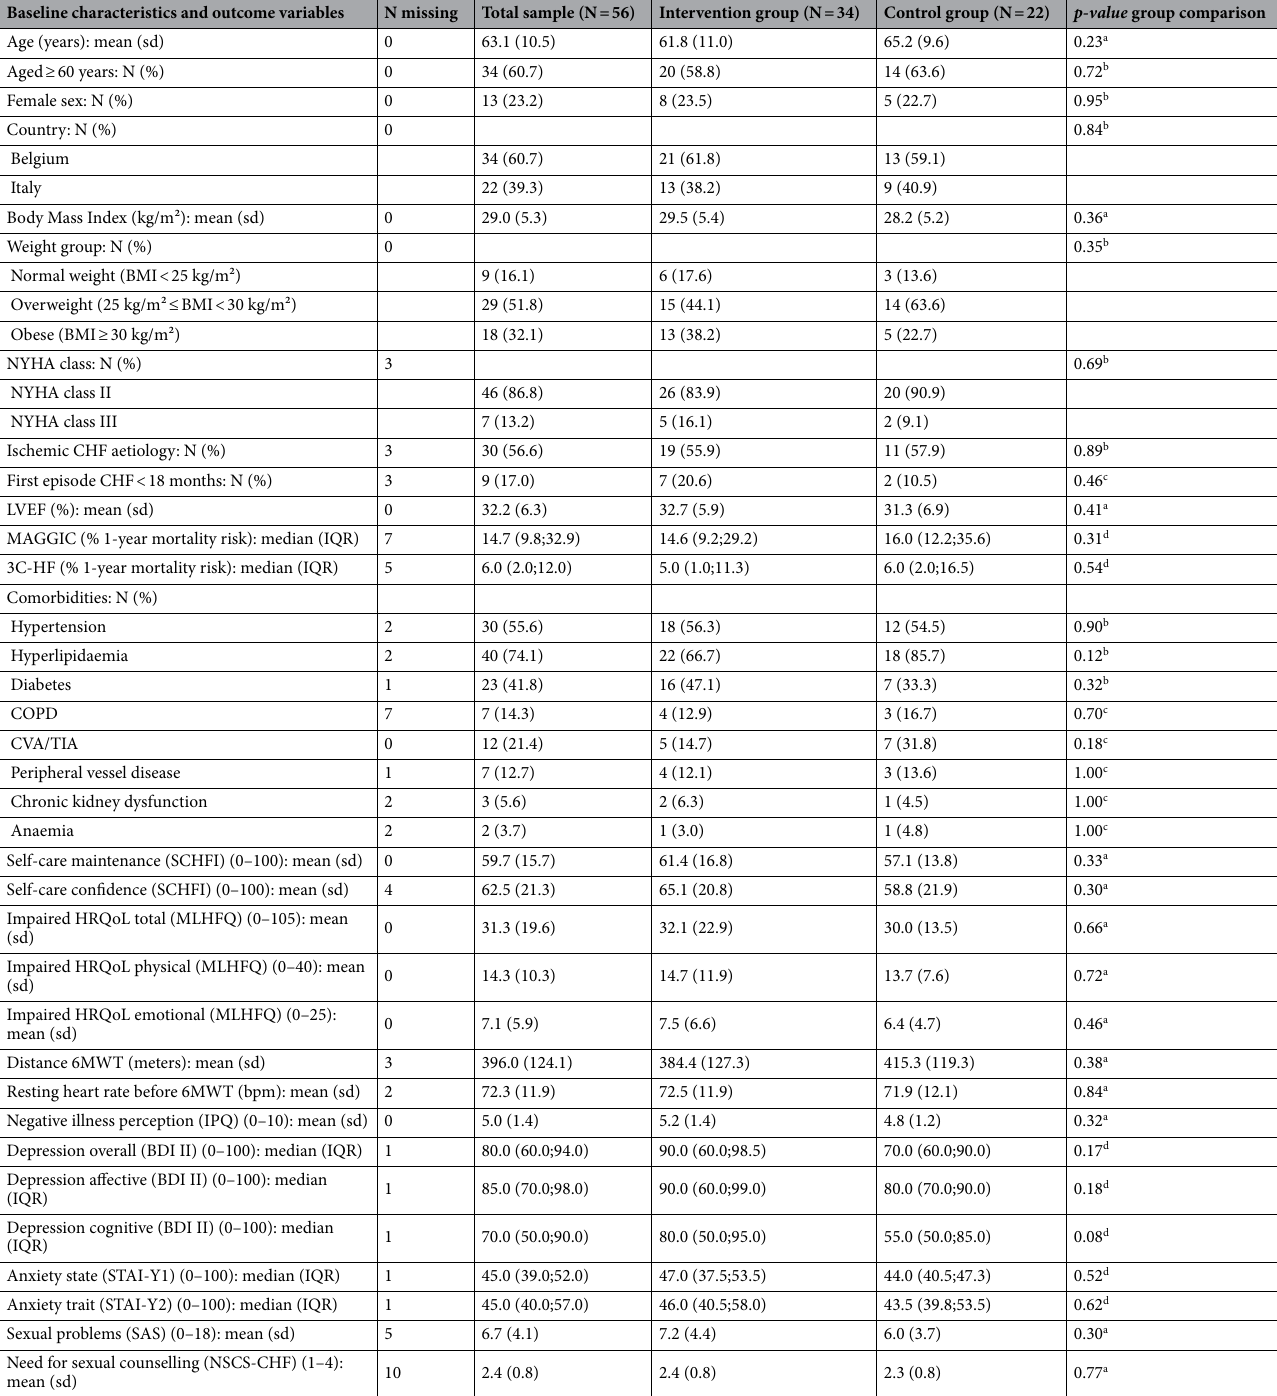
Table 1. Descriptive characteristics of socio-demographic, clinical and outcome variables at T1 in total sample, intervention and control group. BMI, body mass index; NYHA, New York Heart Association;